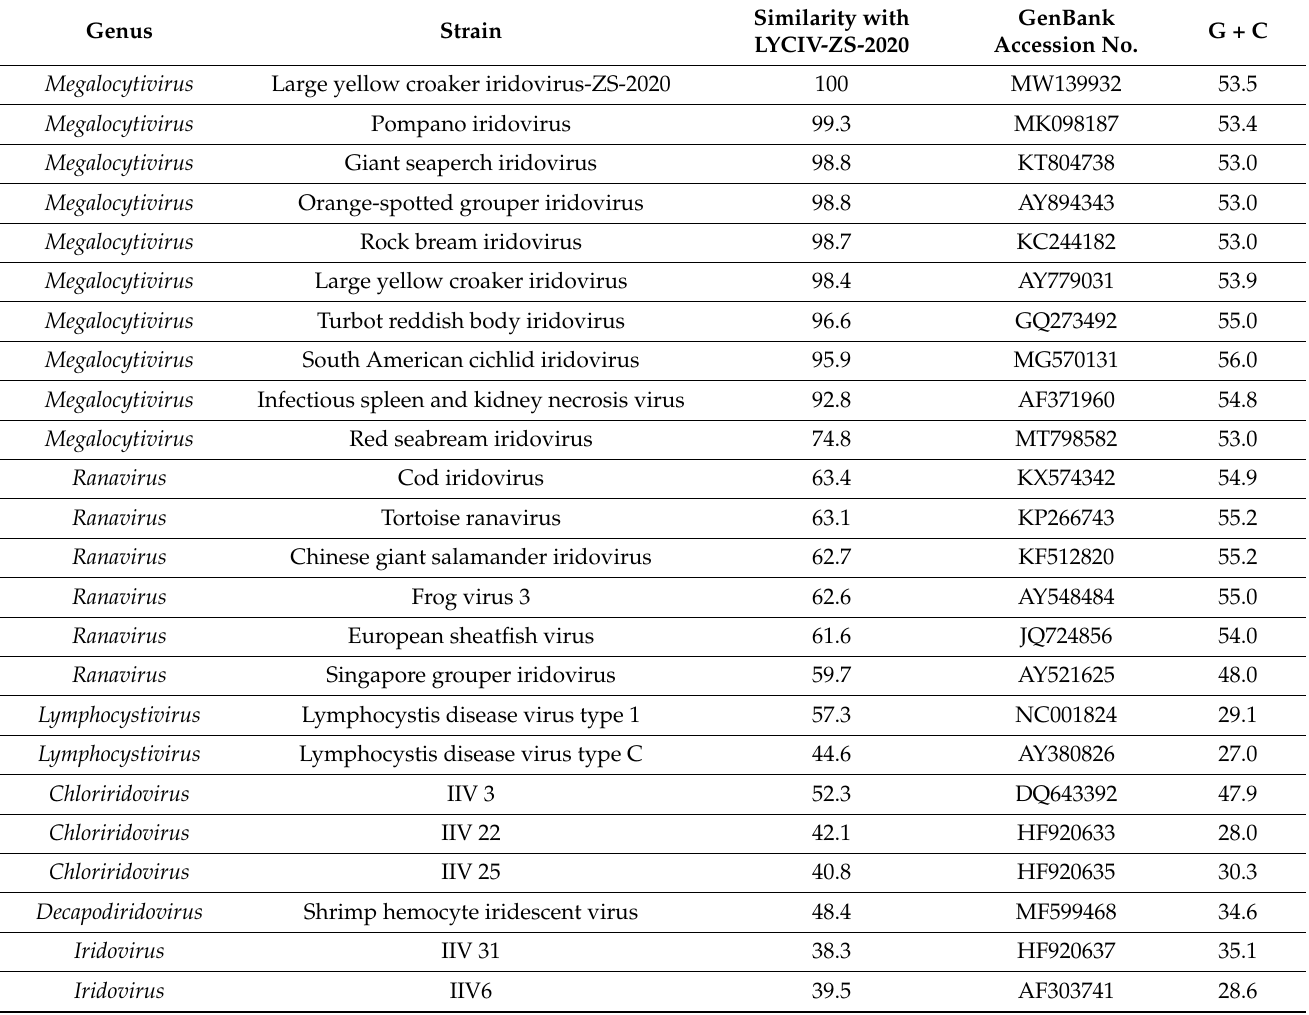
Table 1. Nucleotide identities for the full-length genome of LYCIV-ZS-2020. Genus Strain